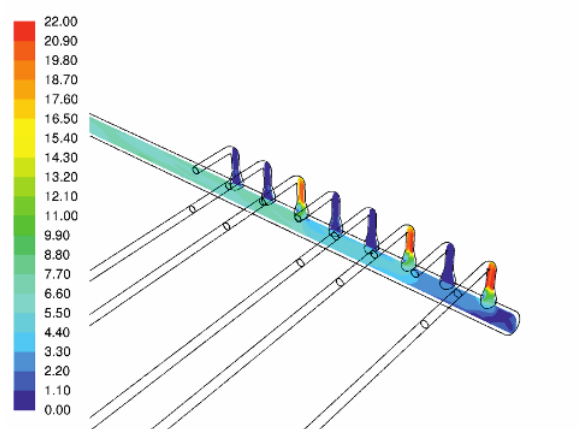
Figure 8: Velocity field in front of metering runs